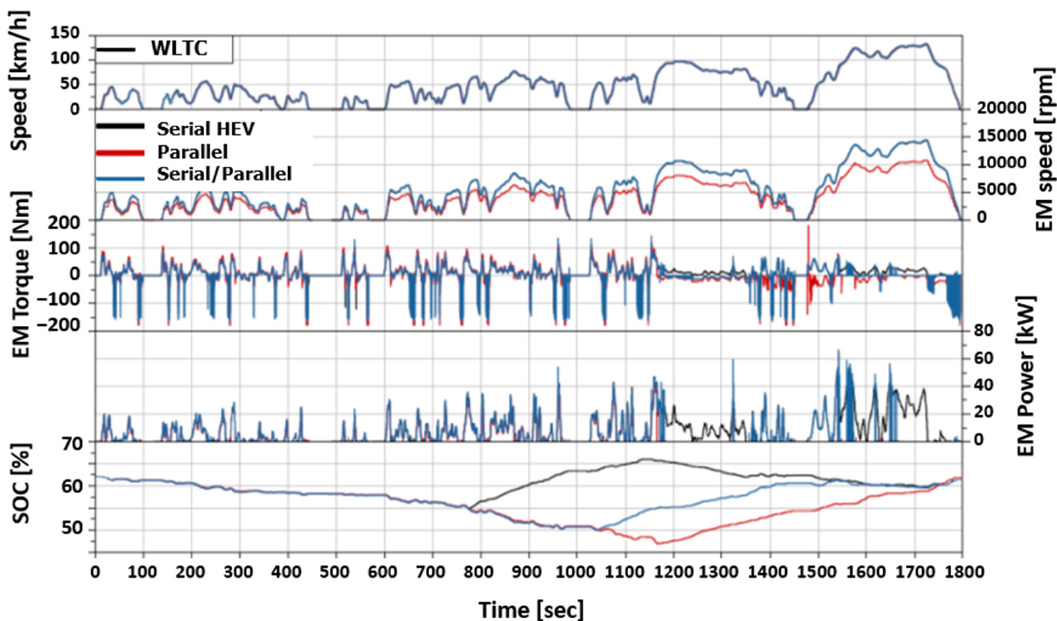
Figure 11. Final results of EM speed, EM torque demand, EM power demand and SOC of serial, parallel and serial/parallel hybrids on WLTC.